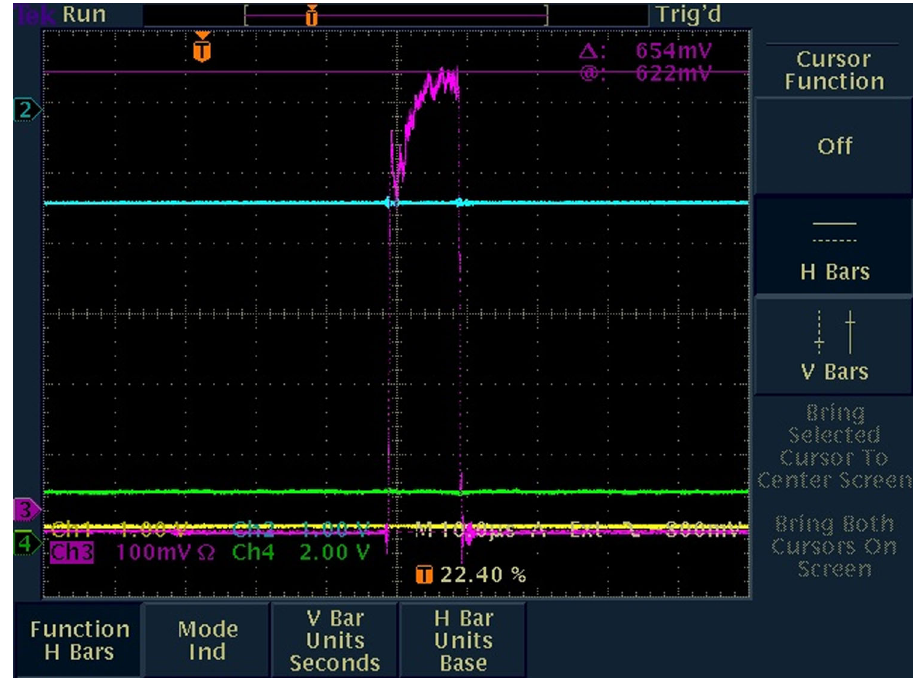
FIG. 33. This is an oscilloscope image of the 40 mA of peak current (magenta curve) measured on a toroid at the start of the DTL. This current was achieved on 25 Jun 2013. The conversion between voltage and beam current is ð 654 mV Þ × ð 0 . 0613 mA = mV Þ ¼ 40 . 1